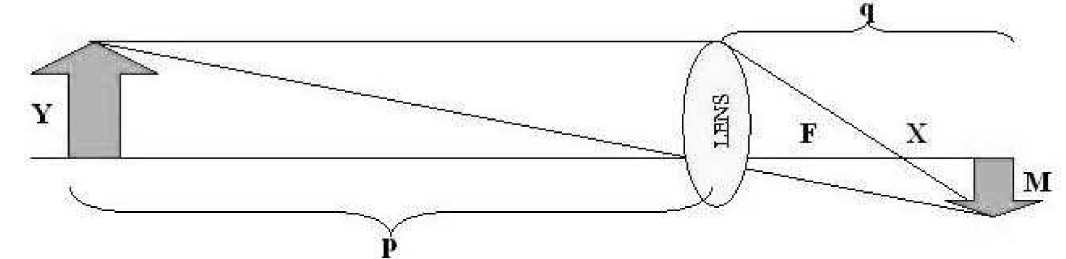
Fig 1. Geometrical formula related to an elephant digital image. Y = (D/F) M, where Y is the height of the elephant at the shoulder, D is the distance from the elephant (p) to the camera, F is the focal length (200 mm), and M is the size of elephant image. Y/M = p/q, where q = F+X. In this case X is irrelevant, so q = F and Y = Mp/F, where p =